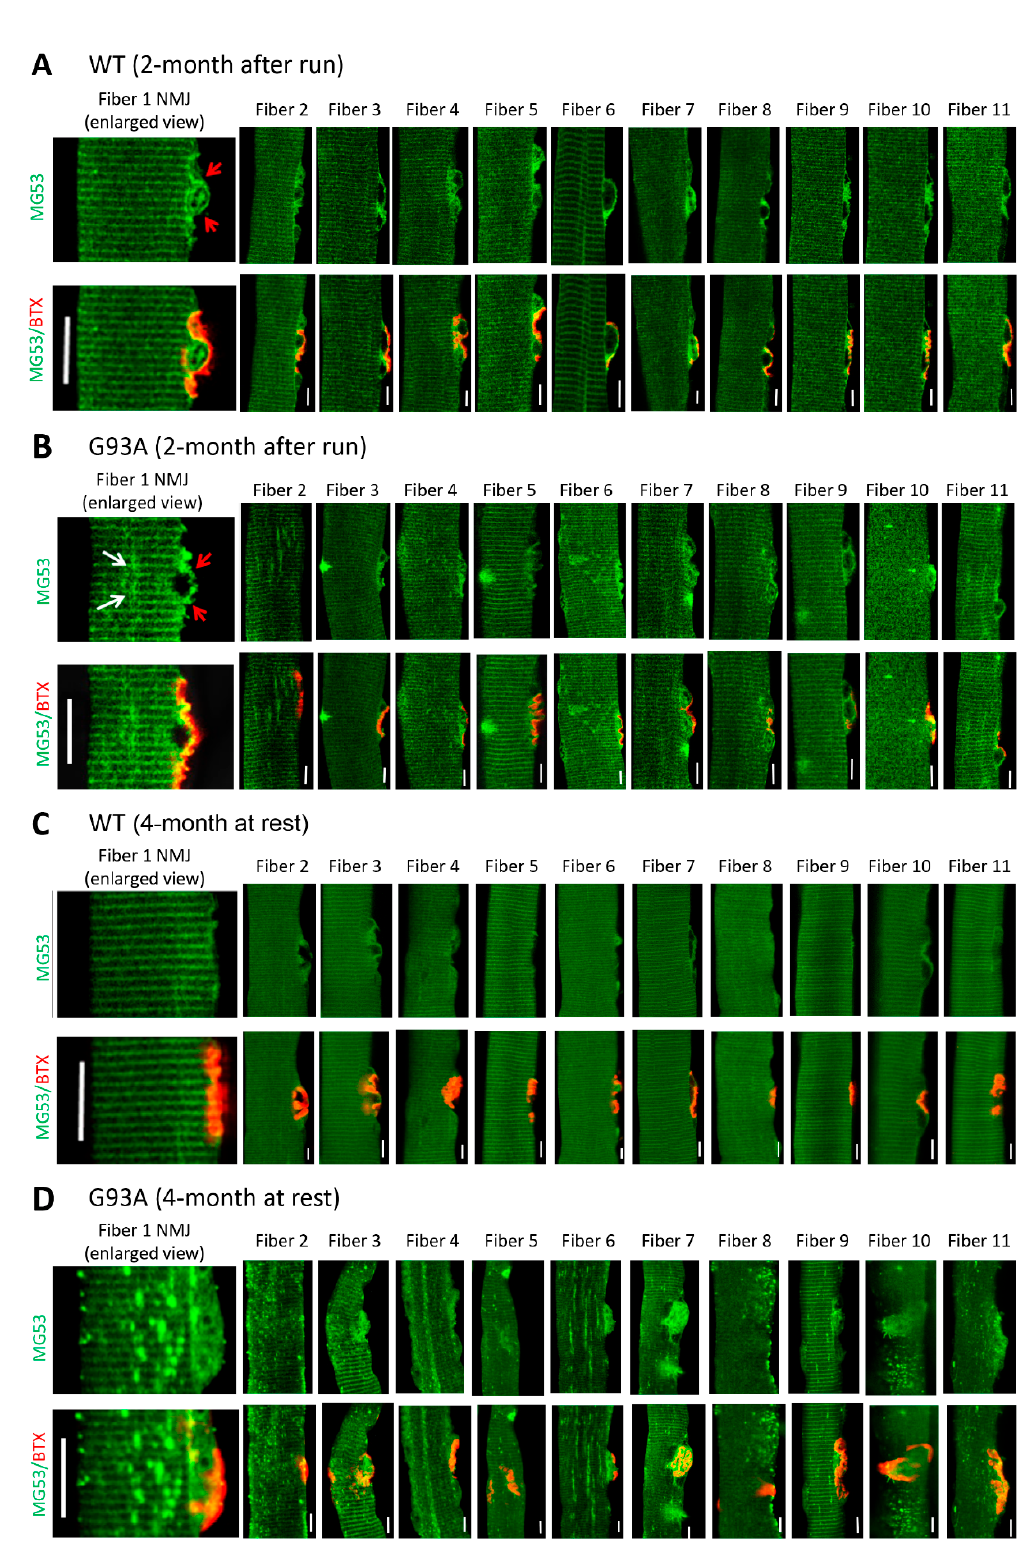
Figure 3. MG53 forms membrane repair patches at NMJ under physiological condition and aggregates near NMJ in G93A myofibers. ( A ) FDB myofibers derived from WT mice (2-month-old) subjected to 30 min running were co-stained with MG53 antibody (green) and BTX (red). MG53 formed membrane patches covering the NMJ site (indicated by red arrows in the enlarged images of NMJ on the left most panel). More representative images of myofibers confirm this observation (right panels). ( B ) FDB myofibers derived from G93A WT mice (2-month-old, before ALS onset) subjected to 30 min running. Similar to the WT myofibers, MG53 also formed membrane patches covering the NMJ site. However, intracellular